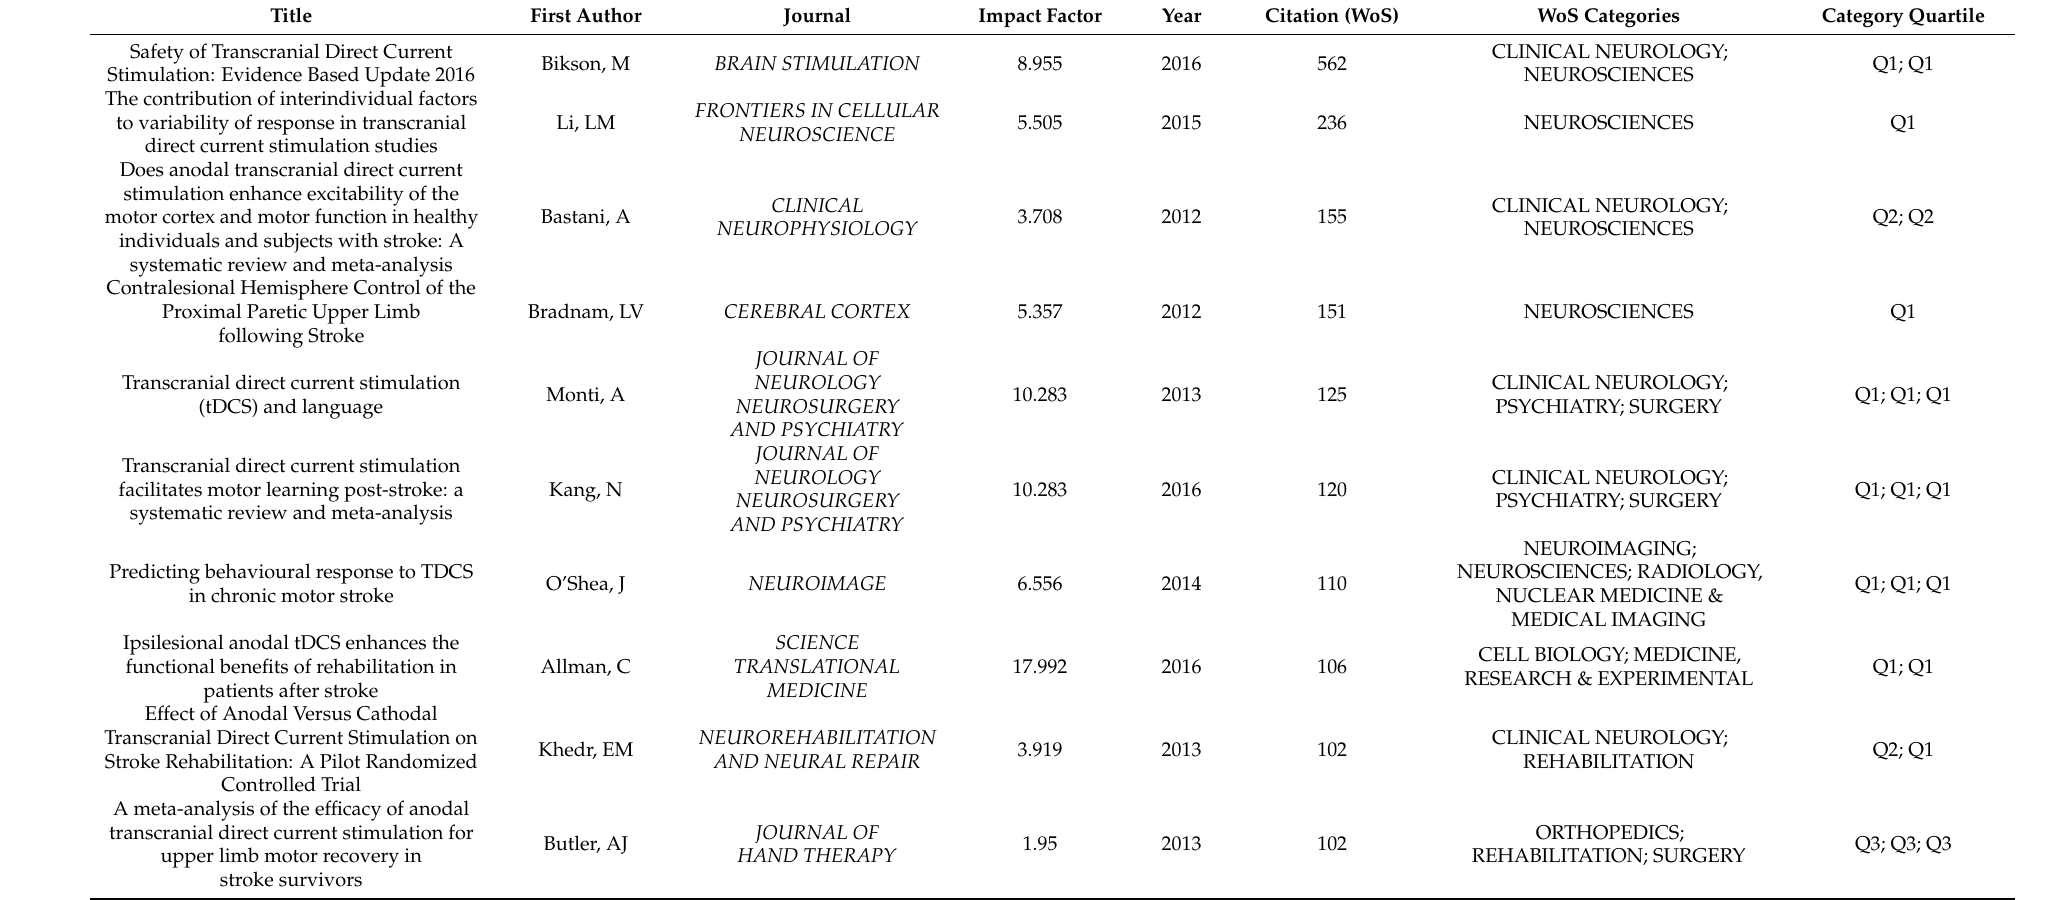
Table 2. Top 10 most cited papers in included